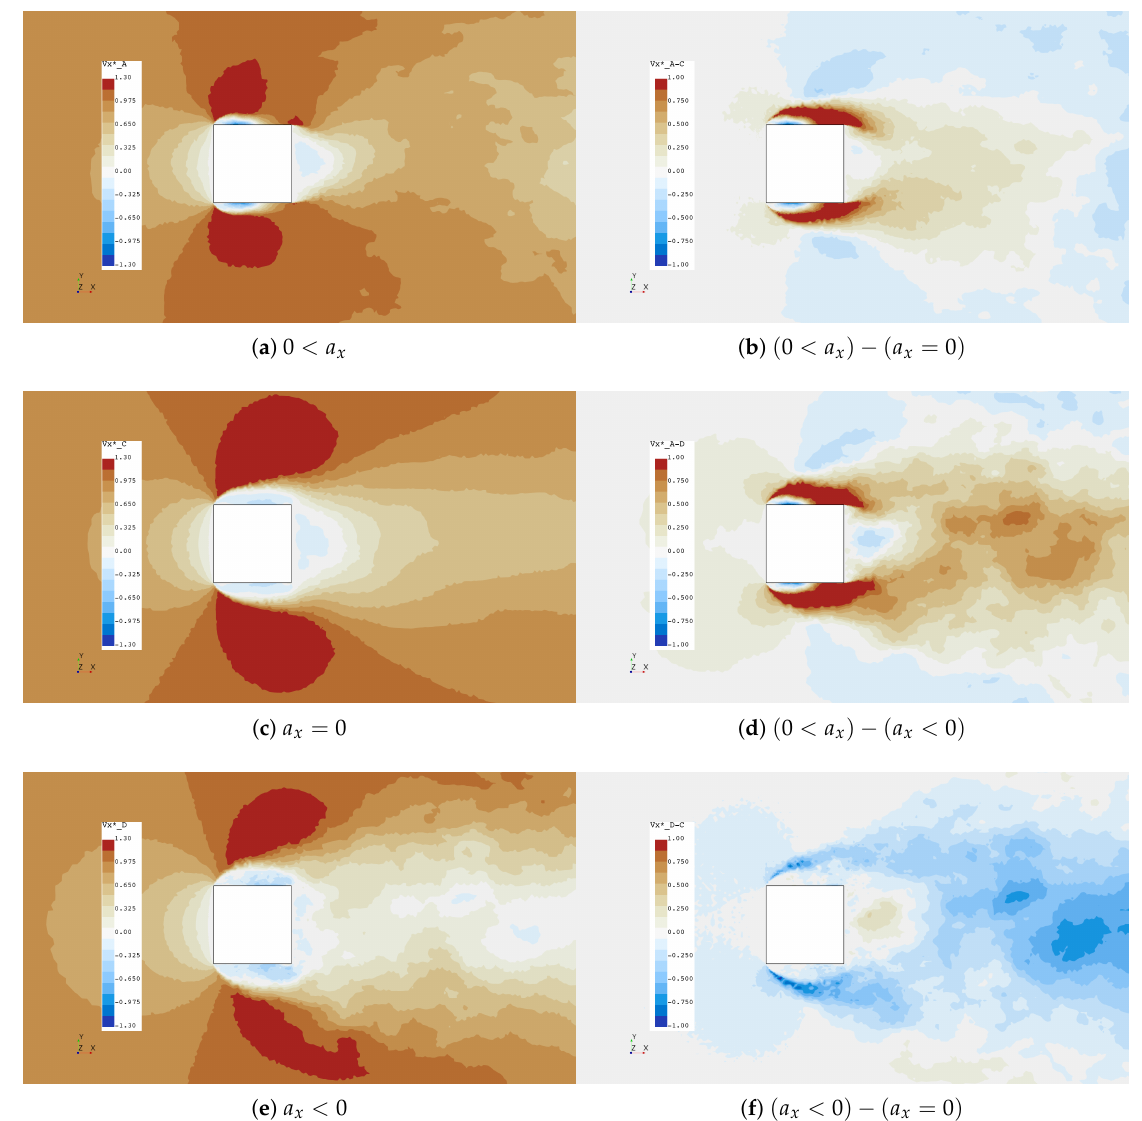
Figure 13. V ∗ x scalar fields and deltas at cylinder center